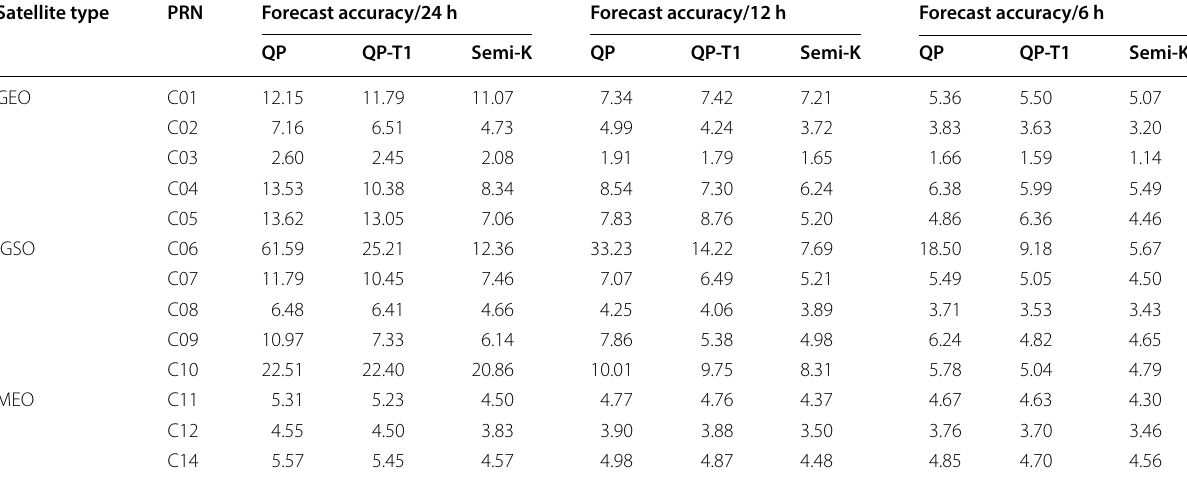
Table 3 Prediction of clock offset in two weeks of Semi-K model (Unit: ns ) Satellite